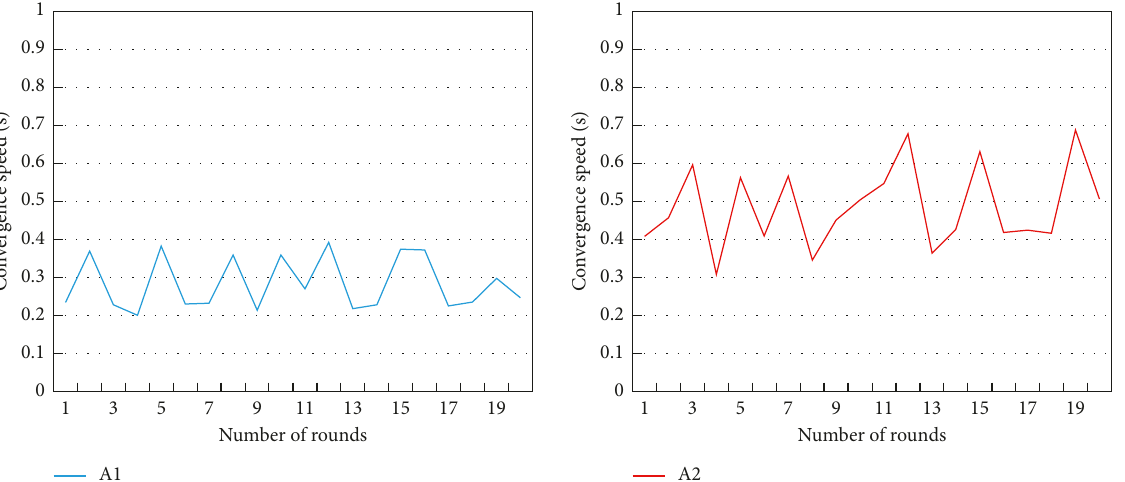
Figure 5: Convergence speed comparison.